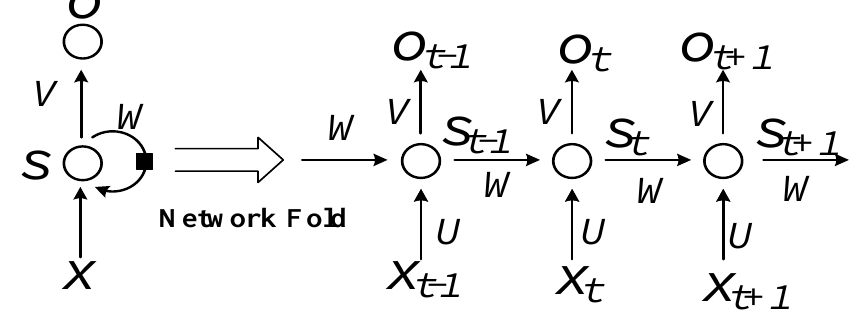
Figure 1. Basic recurrent neural network (RNN) structure.